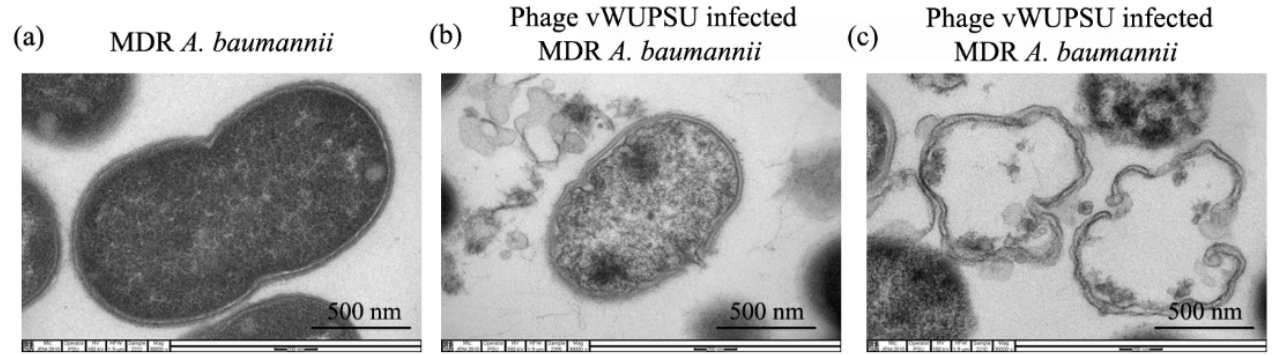
Figure 5. Bacterial cell ultrastructural morphology under TEM. ( a ) MDR A. baumannii ; ( b , c ) phage vWUPSU infected-MDR A. baumannii was observed under a JEOL JEM-2010 transmission electron microscope at an acceleration voltage of 160 kV (30,000 × magnification). The scale bar represents 500 nm.